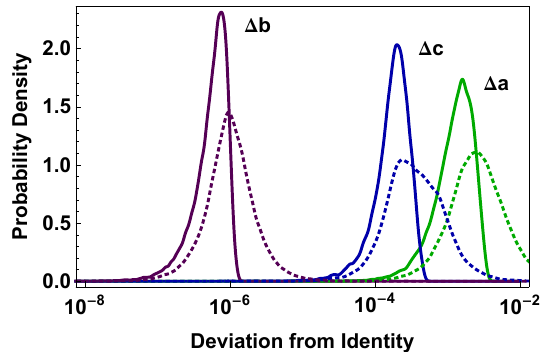
Figure 1 . Left: error of the approximate eigenvectors for down-type Yukawa couplings in arbitrary bases (see text for details). The dotted lines are the corresponding approximations without the maximum length criterion (instead choosing say j = 1 always), showing considerably worse